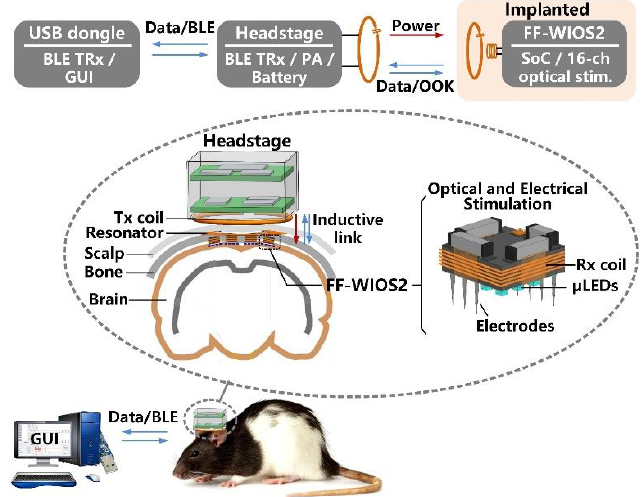
Figure 1. Conceptual view of the system setup for operating multiple mm-sized free-floating wirelessly-powered implantable opto-electro stimulation (FF-WIOS2) devices, distributed on a freely moving rat